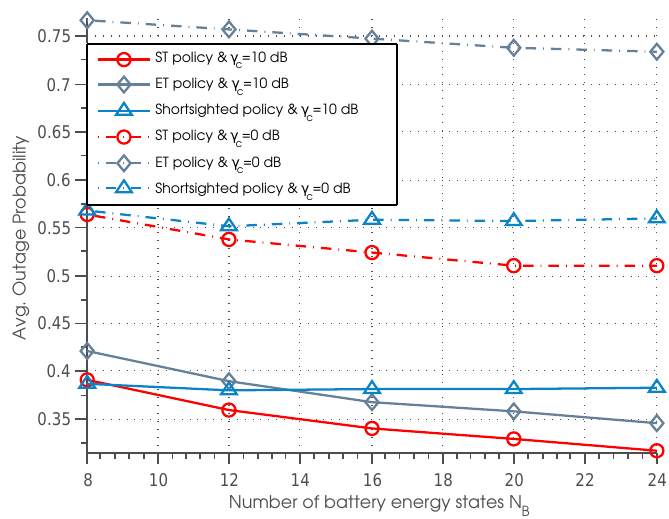
Figure 6. Average outage probability vs. the number of battery energy